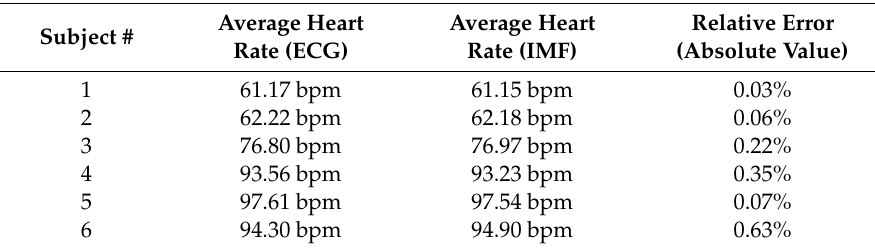
Table 1. Comparison between average heart rates obtained from the baseband ECG signal and from the trans-thoracic impedance trace via empirical mode decomposition